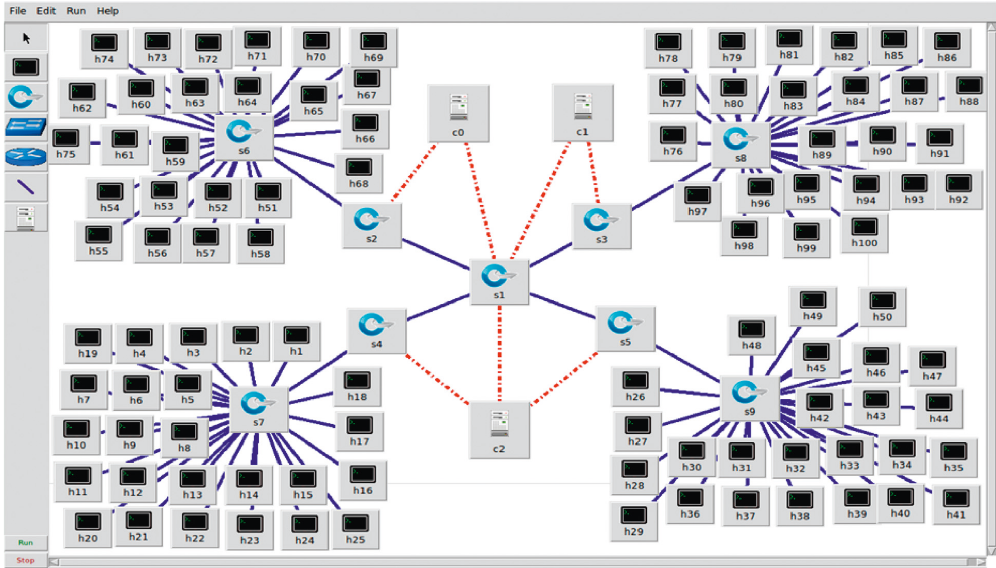
Figure 9: SDN testbed for detection of DDoS attack by using ASVM.